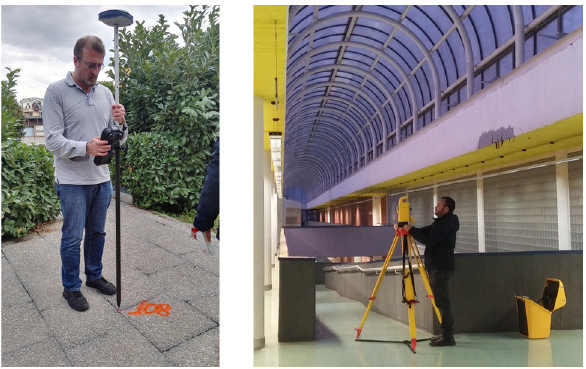
3. Measurements with GPS receiver and total